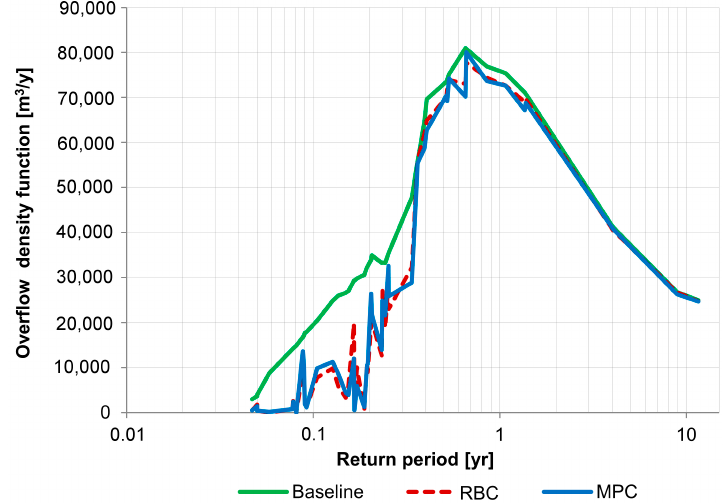
Figure 6. Extrapolated yearly overflow volumes saved by both RTC methods illustrated by the area between the CSO density curves for the baseline scenario curve (solid green line) and the RTC scenarios (RBC in dotted brown line and MPC in solid blue line).